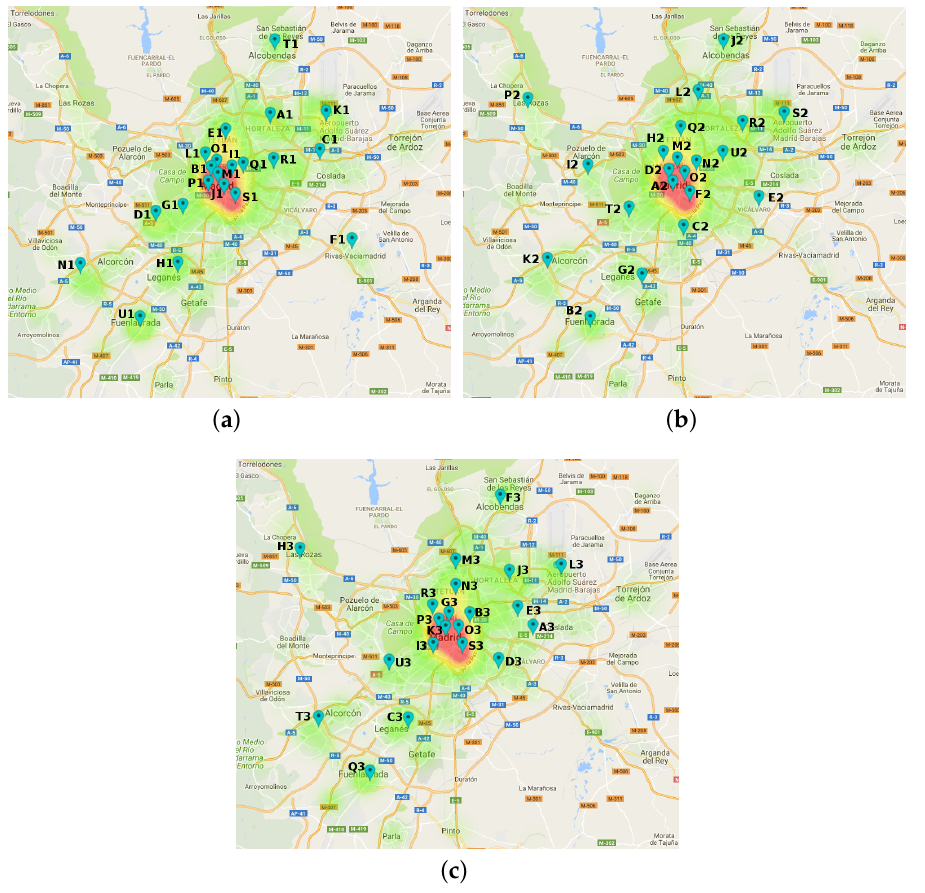
Figure 7. Centroids for MD dataset depicted as pins. The labelled ones are further discussed